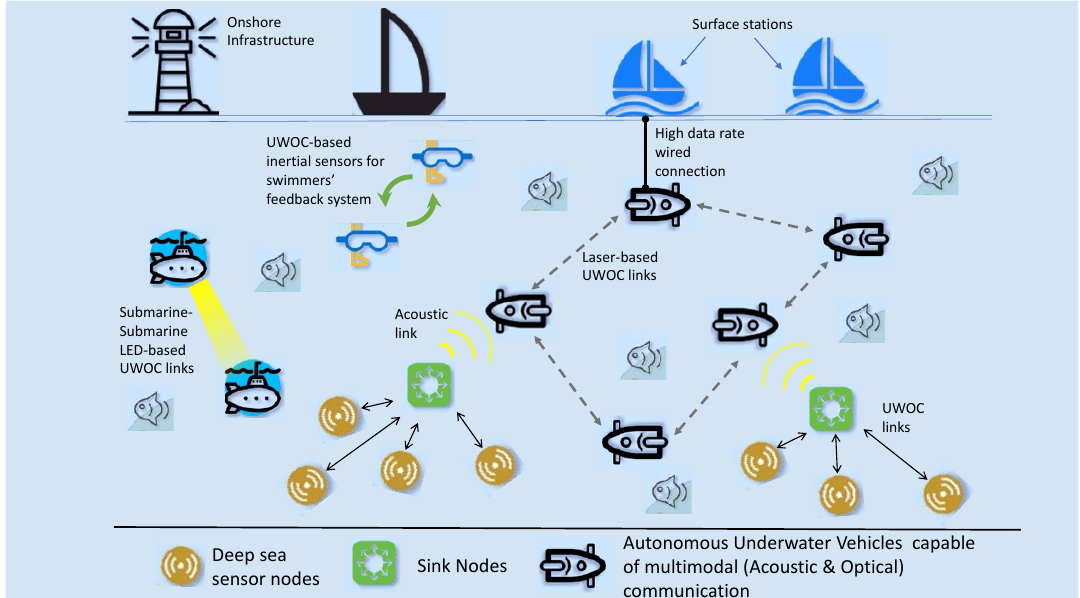
Figure 1. A general Internet of Underwater Things (IoUTs)